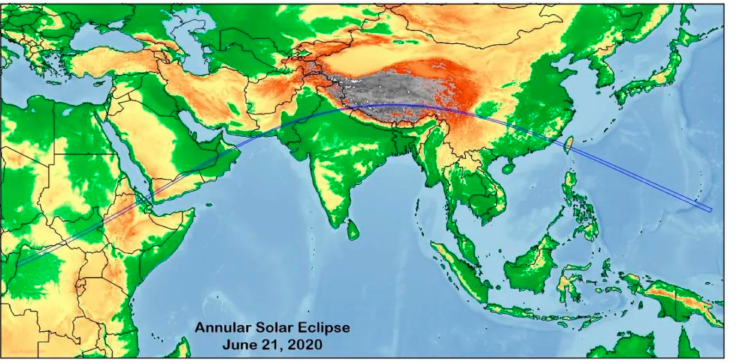
Figure 2. Annular eclipse path on 21 June 2020. (source: http://tech.sina.com.cn/d/s/2020-06- 17/doc-iircuyvi8955614.shtml?cre=tianyi&mod=pchp&loc=34&r=0&rfunc=46&tj=none&tr=12 (ac- cessed on 6 February